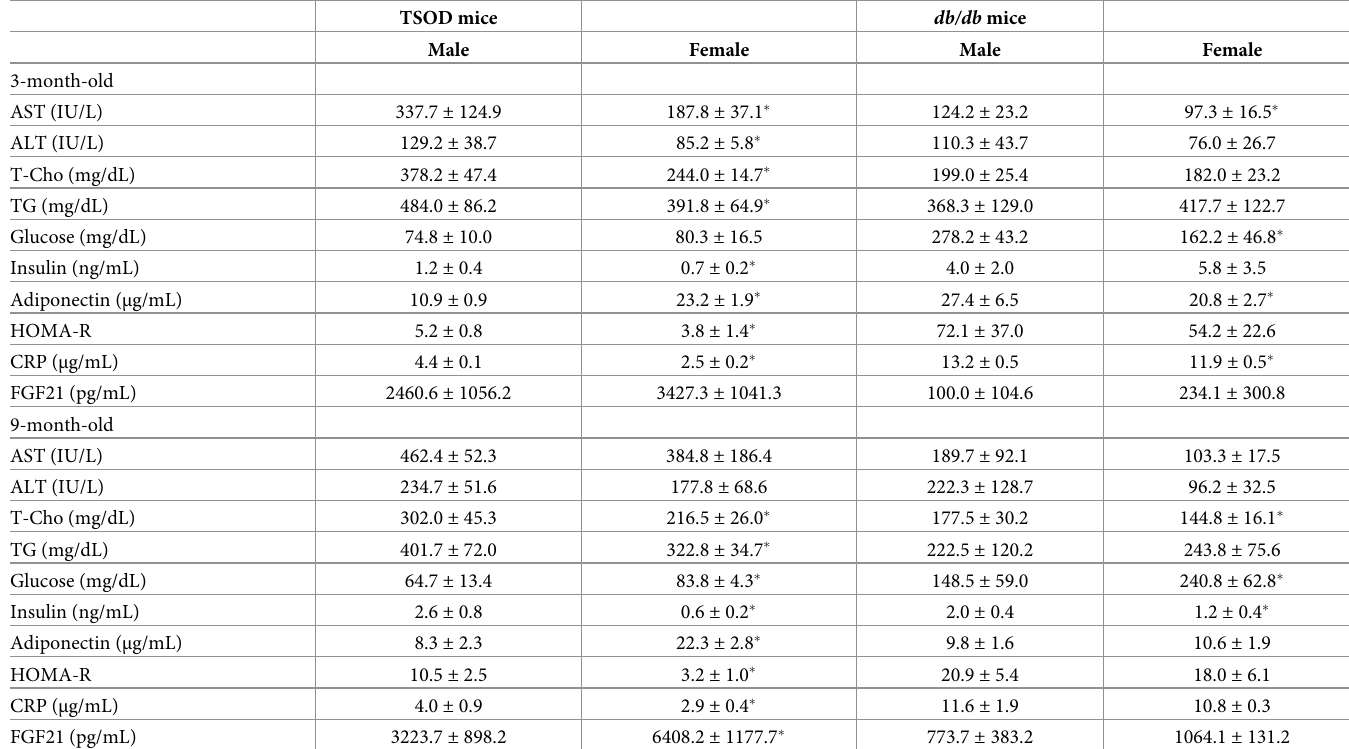
Table 3. Biochemical data of serum. TSOD mice db/db mice Male